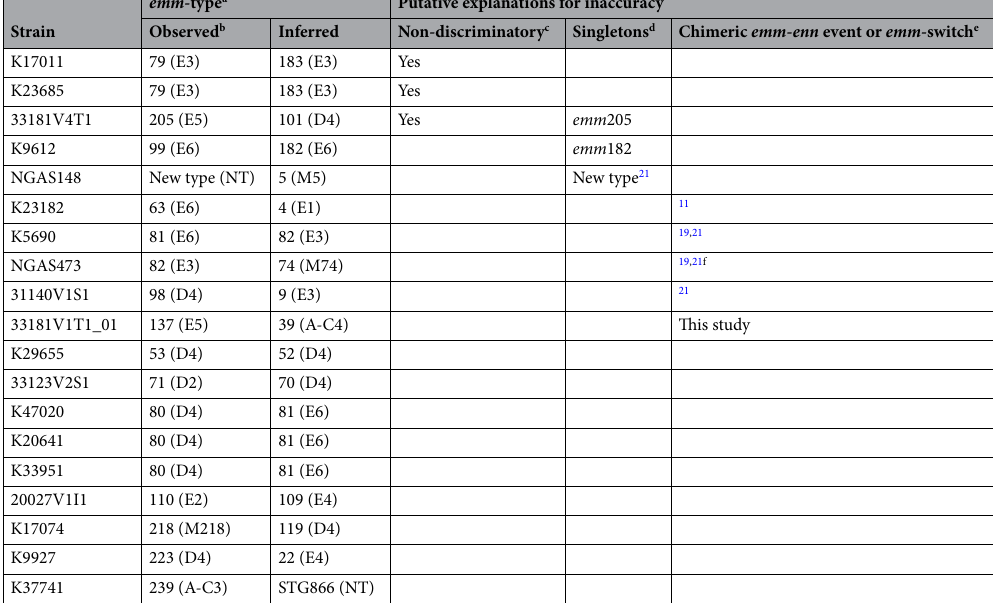
Table 3. Examples of inaccurately inferred GAS emm -type using the most accurate Guided random forest algorithm and the optimal set of response regulator (RR) allele types. a emm -cluster type in brackets. b The observed or published emm -type. c Prior to the random forest testing, it was known that the variation between the RR alleles in the feature set was not able to discriminate emm 79 from emm 183, or emm 101 from emm 205. d Singleton denotes where the dataset contained only one representative of this emm -type. e Chimeric emm - enn events have been observed in isolates of this emm -type. f emm -switching has also been inferred in this isolate.